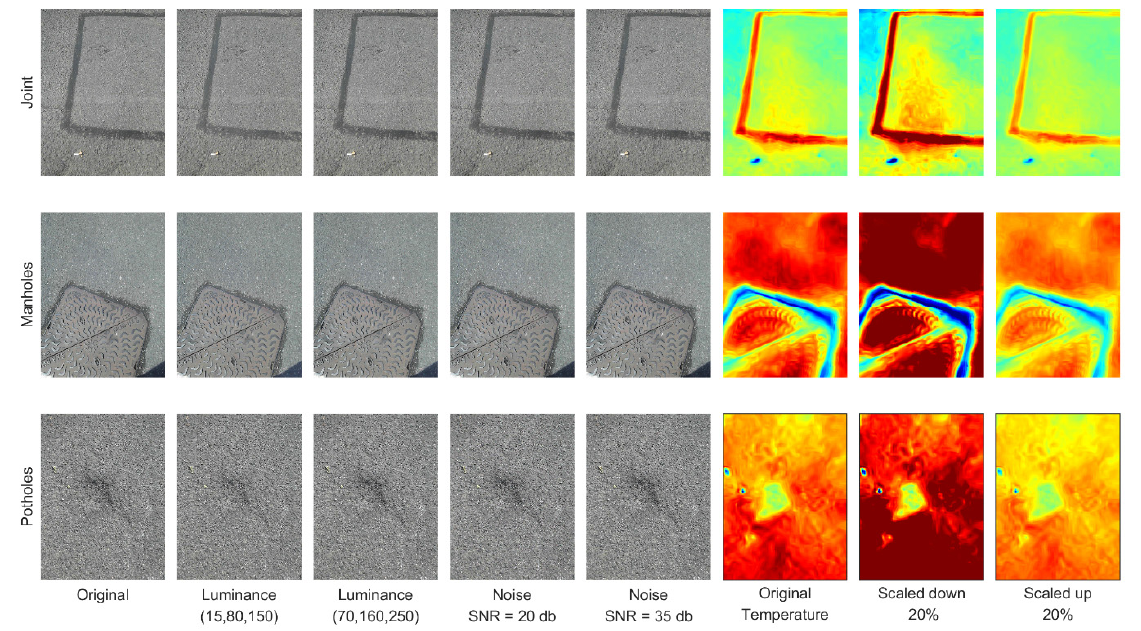
Figure 4. Data augmentation of joint, manholes and potholes.